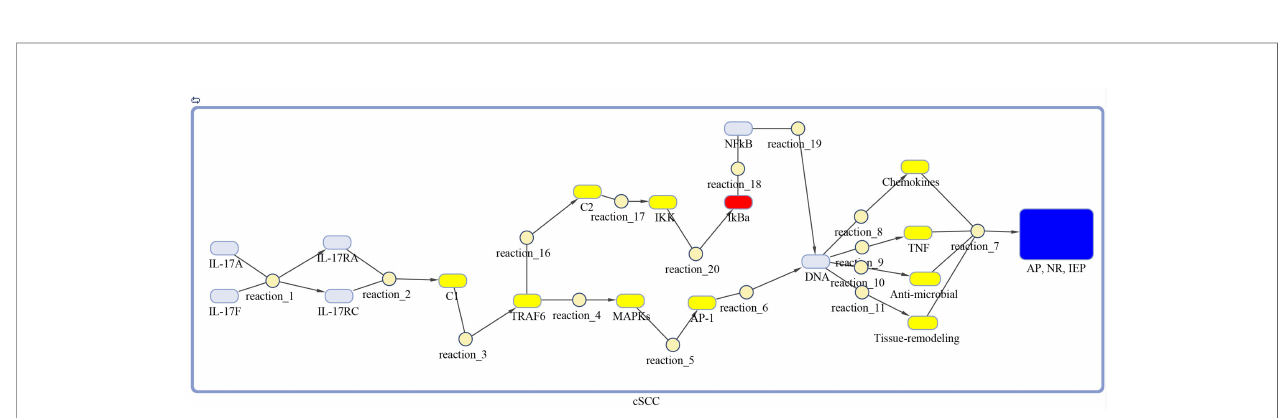
FIGURE 4 | Model of IL-17 signaling pathway for cSCC. The model is built as network of species (oval) and reactions (circle), which are connected by edges. Species represent biological entities of the pathway, and are color coded. Dark blue color shows processes of autoimmune pathology, neutrophil recruitment, and immunity to extracellular pathogens, yellow color depicts DEGs, red color shows inhibitors, and sky-blue color represents genes that are part of the pathway, however, not differentially expressed. The species MAPKs includes MAPK3, MAPK9, MAPK10, MAPK11, and MAPK14. Chemokines includes CXCL1, CXCL2, CXCL8, and CCL20. The species Anti-microbial includes DEFB4A, DEFB4B, S100A7, S100A8, S100A9, and LCN2 genes. Tissue remodeling includes MMP1, MMP3, MMP9, and MMP13 genes. C1, C2, C3 and AP-1 are complexes of genes. C1 includes Hsp90 and Act1. C2 includes TAB2, TAB3 and TAK1 genes. AP-1 includes FOSL1 and JUN